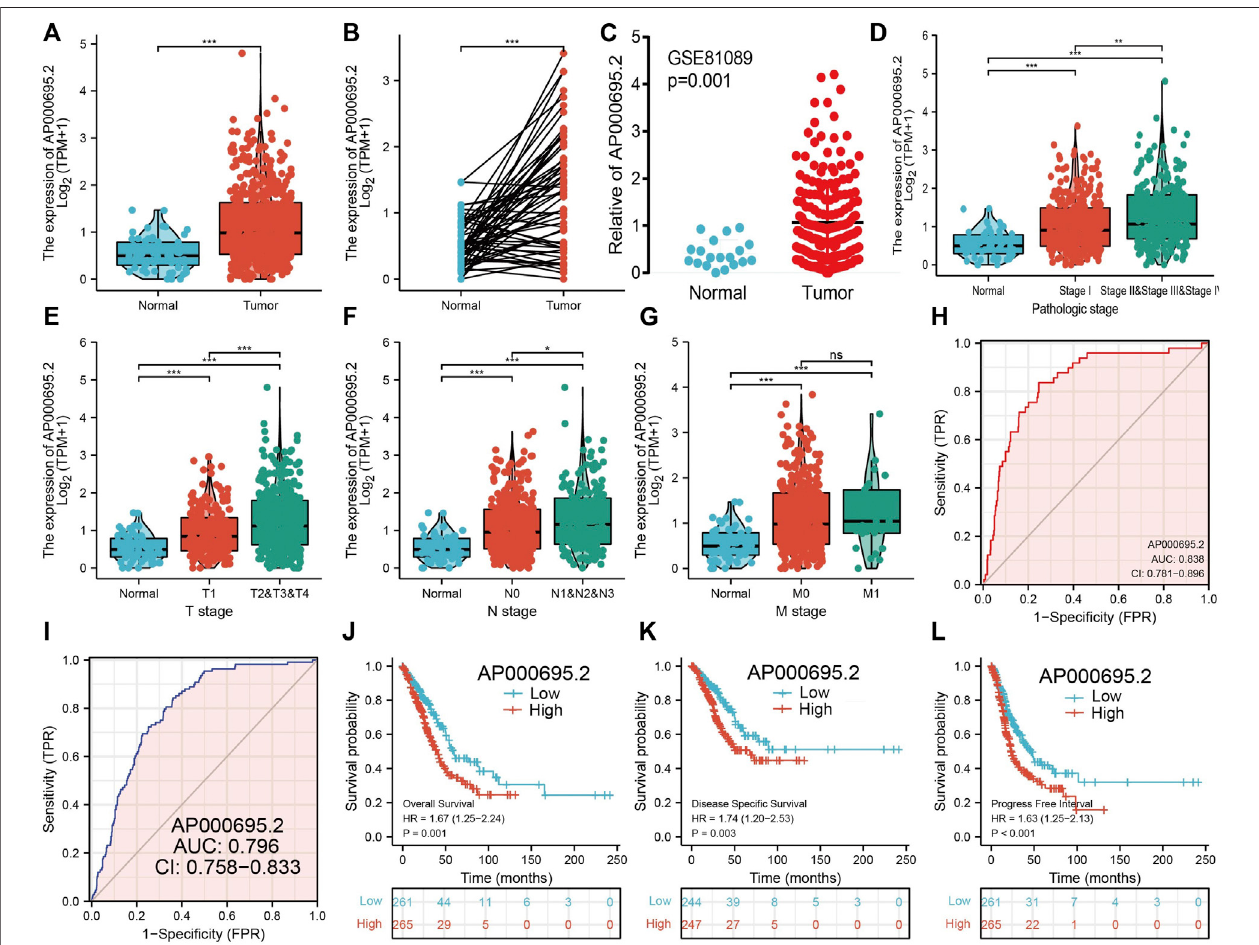
FIGURE 2 | Clinical signi fi cance of lncRNA-AP000695.2 in lung adenocarcinoma. (A) Expression of lncRNA-AP000695.2 in lung cancer based on TCGA dataset. (B) Expression levels of lncRNA-AP000695.2 in 59 paired adjacent normal tissues and paired samples. (C) Expression levels of lncRNA-AP000695.2 in lung cancer based on the GEO dataset. (D – G) Correlation between lncRNA-AP000695.2 expression and clinical parameters includes pathological and TNM stages. (H – I) ROC curves were used to determine the diagnostic value of lncRNA-AP000695.2 in lung adenocarcinoma based on TCGA-LUAD and GEO datasets. (J – L) Kaplan – Meier survival curves showed that lung adenocarcinoma patients with high-lncRNA-AP000695.2 expression exhibited poor overall survival, disease-speci fi c survival, and progression-free survival based on TCGA-LUAD dataset. * p < 0.05, ** p < 0.01, and *** p < 0.001.